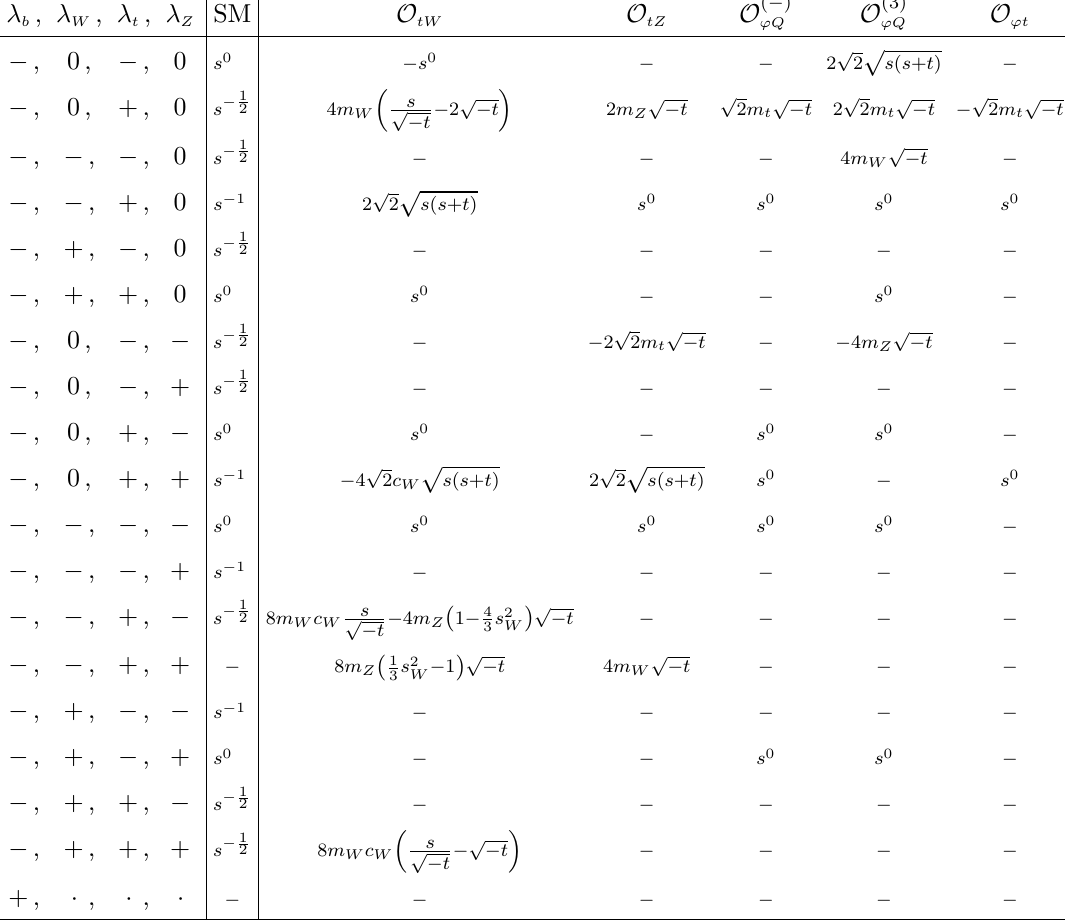
Table 5 . Top quark operator contributions to the individual helicity amplitudes of b W → t Z scattering in the high-energy limit, s, − t (cid:29) v . λ i denotes the helicity/polarisation of the external leg i and the contribution of each operator O j omits an overall factor of c i / Λ 2 . “ − ” entries denote SMEFT contributions that decrease with energy. The energy dependence of the corresponding SM helicity amplitude is given in a schematic form such that the high-energy behaviour of each interference term can be inferred. As indicated by the last row, all amplitudes with a right-handed b -quark are not generated since m b = 0 is enforced by our flavor symmetry